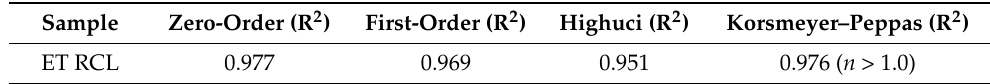
Figure 4. In vitro release of TPC in PBS:EtOH (7:3 v / v ) from ET RCL and RCL solution. To evaluate release mechanisms and kinetics, the in vitro release data were fitted to different kinetics models: zero-order, first-order, Higuchi, and Korsmeyer–Peppas. Table 4 shows the parameters of fitted release data. The results revealed that the release of TPC from ethosomes follows zero-order release, providing a constant release of TPC over time. Table 4. Release kinetic parameters for ET